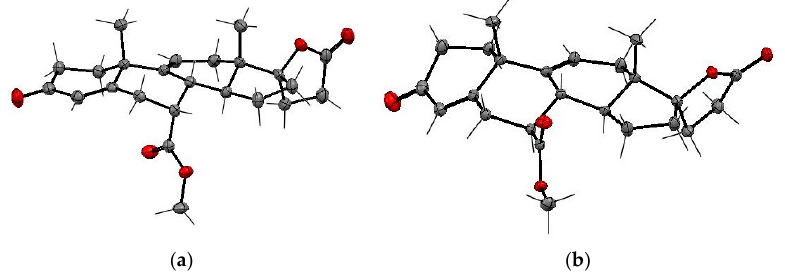
Figure 5. Molecular structure of the isomeric 9(11)-enesters: ( a ) (7 α ,17 α )- 7 and ( b ) (7 β ,17 α )- 7a . Table 5. Summary of crystallographic data and structure refinement for (7 α ,17 α )-11(12)-enester 7b and (7 α ,11 β ,17 α )-9,11-dichloro derivative 13 .